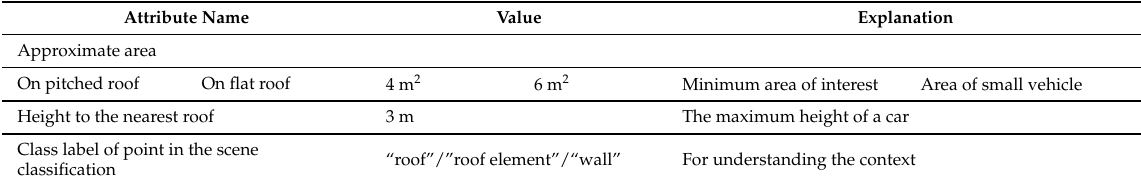
Table 3. Defined parameter values for the rule based classifier. Tabel 3. Defined parameter values for the rule based classifier.